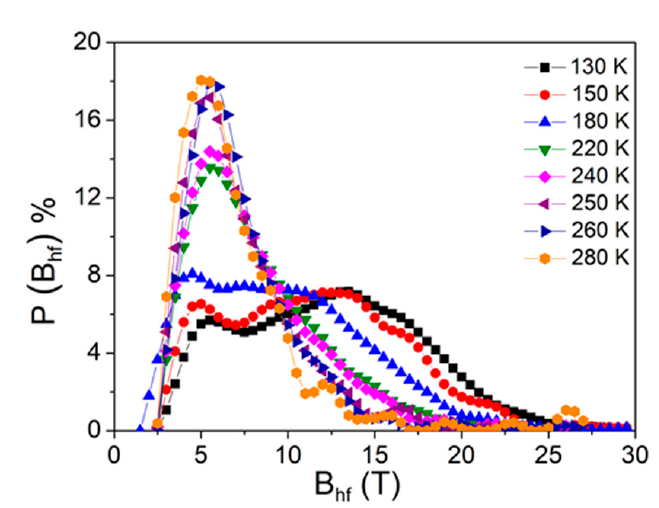
Figure 4. Hyperfine field distributions for the Mössbauer spectra collected at the indicated temperatures.